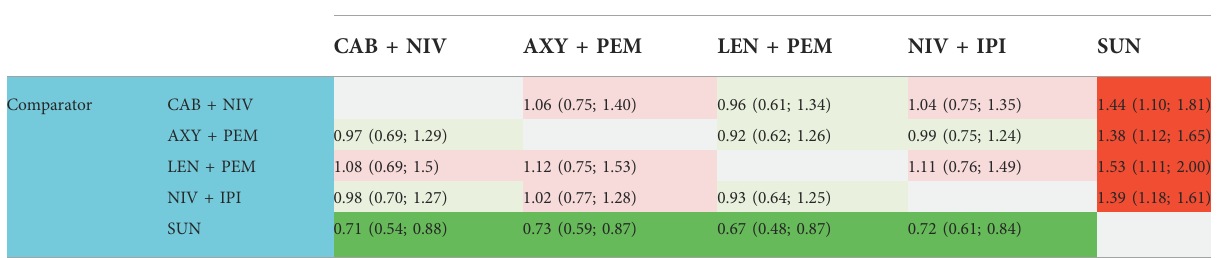
Thevaluesineachcellrepresenttherelativetreatmenteffectfortheinterventiononthetopwhencomparedtotheinterventionontheleft.Greensuggestsarelativetreatmentbene fi t(light greenanonsigni fi cantbene fi t,anddarkgreenasigni fi cantbene fi t).Redsuggestsarelativetreatmentharm(lightredanonsigni fi cantharm,anddarkredasigni fi cantharm).AXY,axitinib; CAB, cabozantinib; IPI, ipilimumab; LEN, lenvatinib; PEM, pembrolizumab; NIV, nivolumab; SUN,